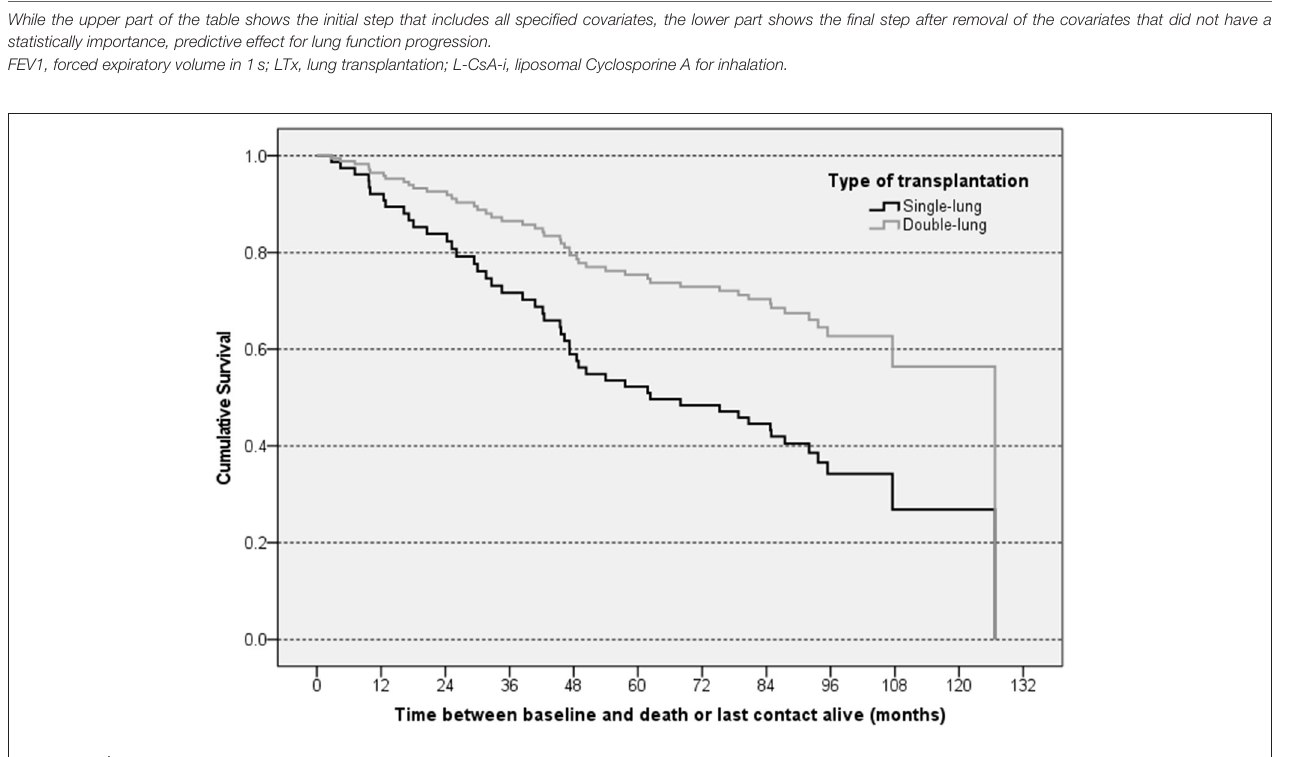
FIGURE 4 | Graphical illustration of estimated cumulative survival for subjects with different types of LTx—Cox regression analysis. The “steps” in the curves of the subsets represent predicted events resulting from the regression